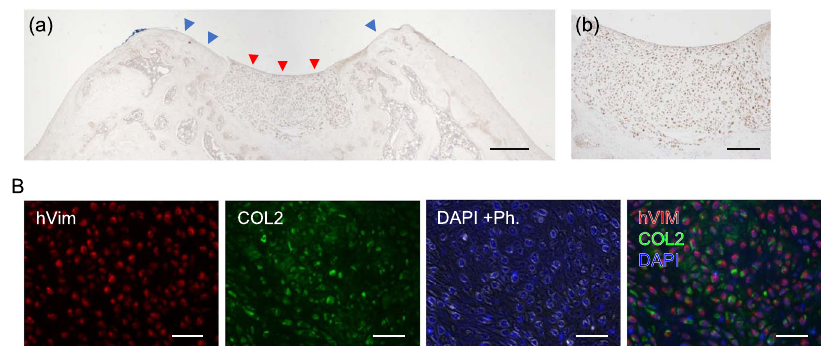
Fig. 6 Transplanted human chondrocyte engraftment accompanied by type II collagen deposition. A (a) Human antigen-speci fi c vimentin staining of a JCC sheet-treated sample. Red arrowheads indicate regenerated cartilage. Blue arrowheads indicate host cartilage. Bar: 500 µm (b) Magni fi ed area of regenerated cartilage with human antigen-speci fi c vimentin staining. Bar: 200 µm. B Double staining of human vimentin (red) and type II collagen (green). DAPI + Ph: DAPI and phase-contrast image to show nuclei (blue with white edge). The right panel shows the merged image of human vimentin, type II collagen, and DAPI. Bars: 200 µm. A histology sample of 4 weeks after treatment is shown.